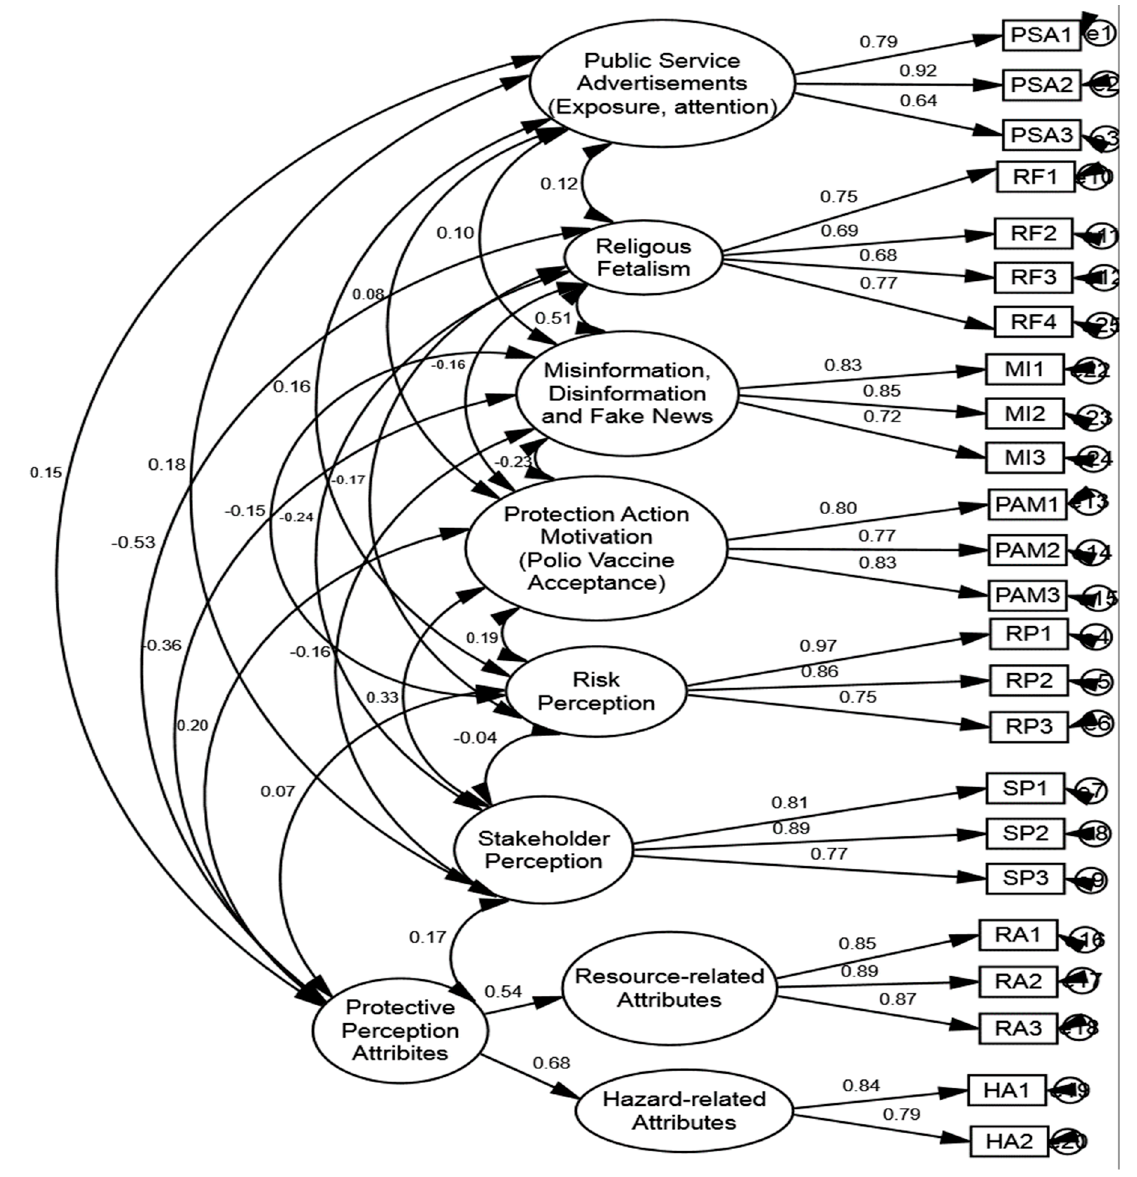
Figure 2. Measurement model. Table 2. Item standardized weights. Variables